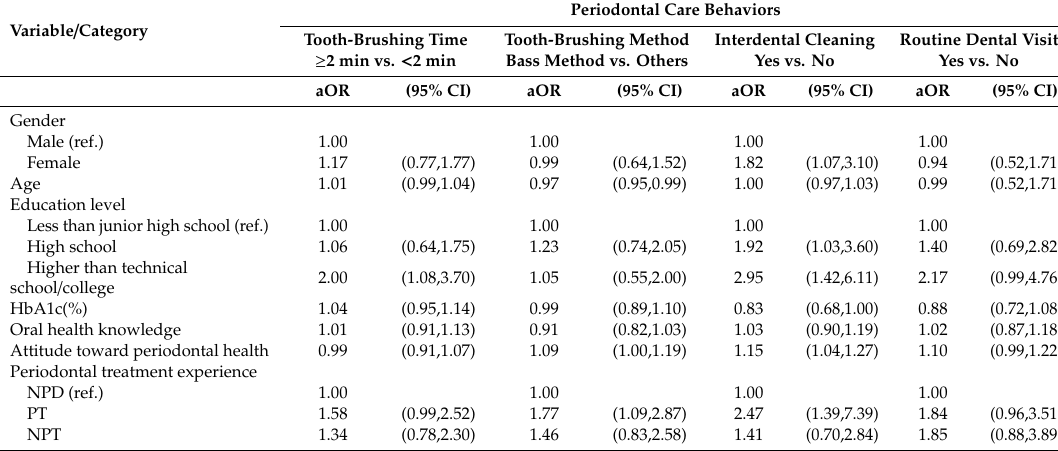
Table 3. Periodontal treatment experience and selected variables related to periodontal care behaviors in T2DM patients in multivariate logistic regression model Variable / Category Gender Male (ref.)